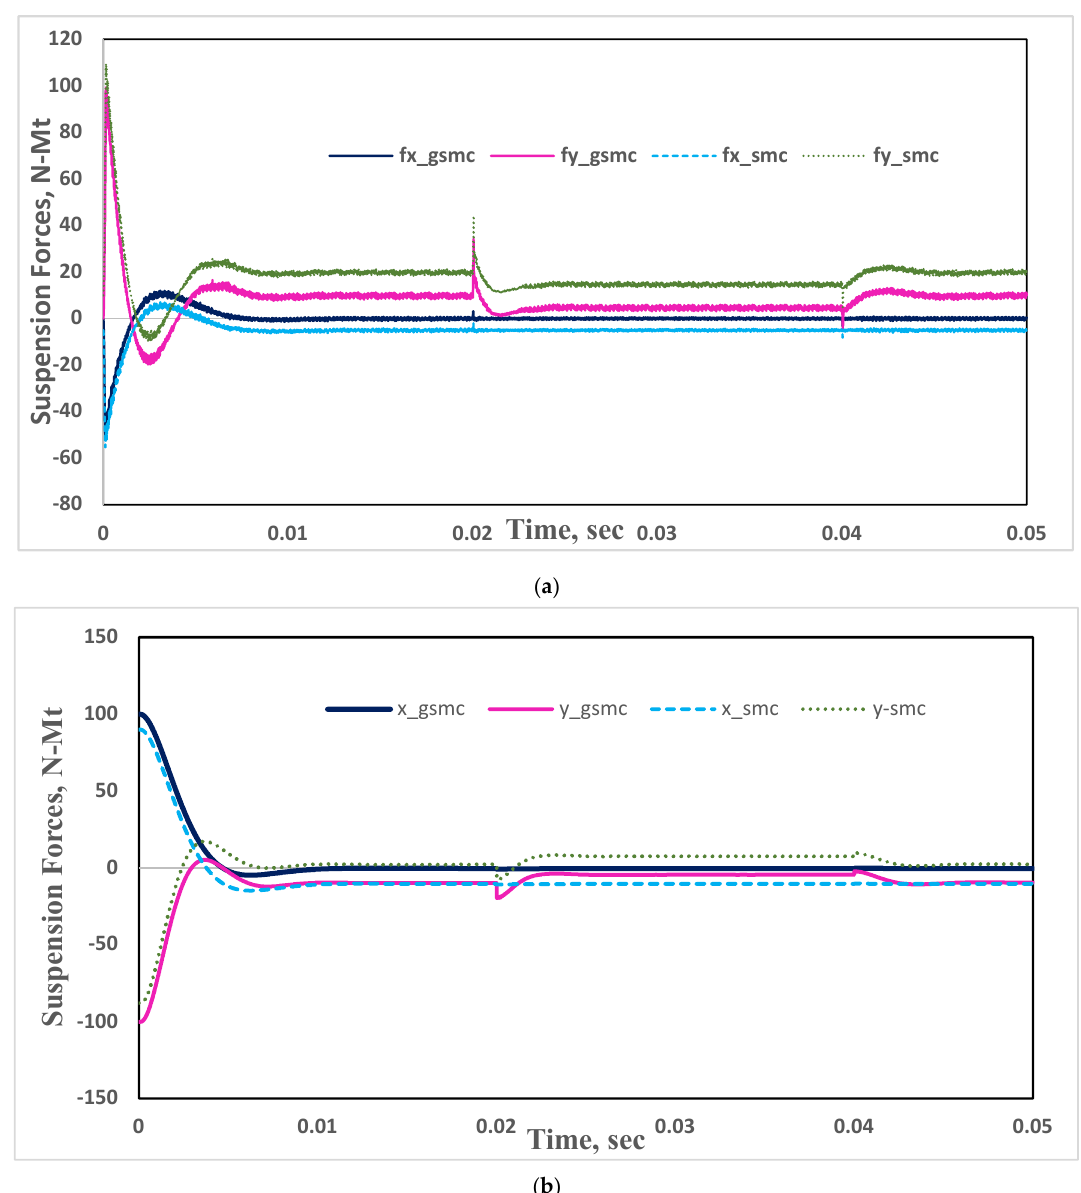
Figure 25. Change in rotor weights. ( a ). Suspension forces when rotor weights are changed. ( b ). Rotor X- and Y-directional displacements when rotor weights are changed.